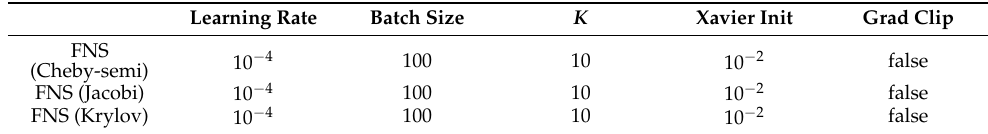
Table A1. Training hyperparameters for anisotropic diffusion equation.